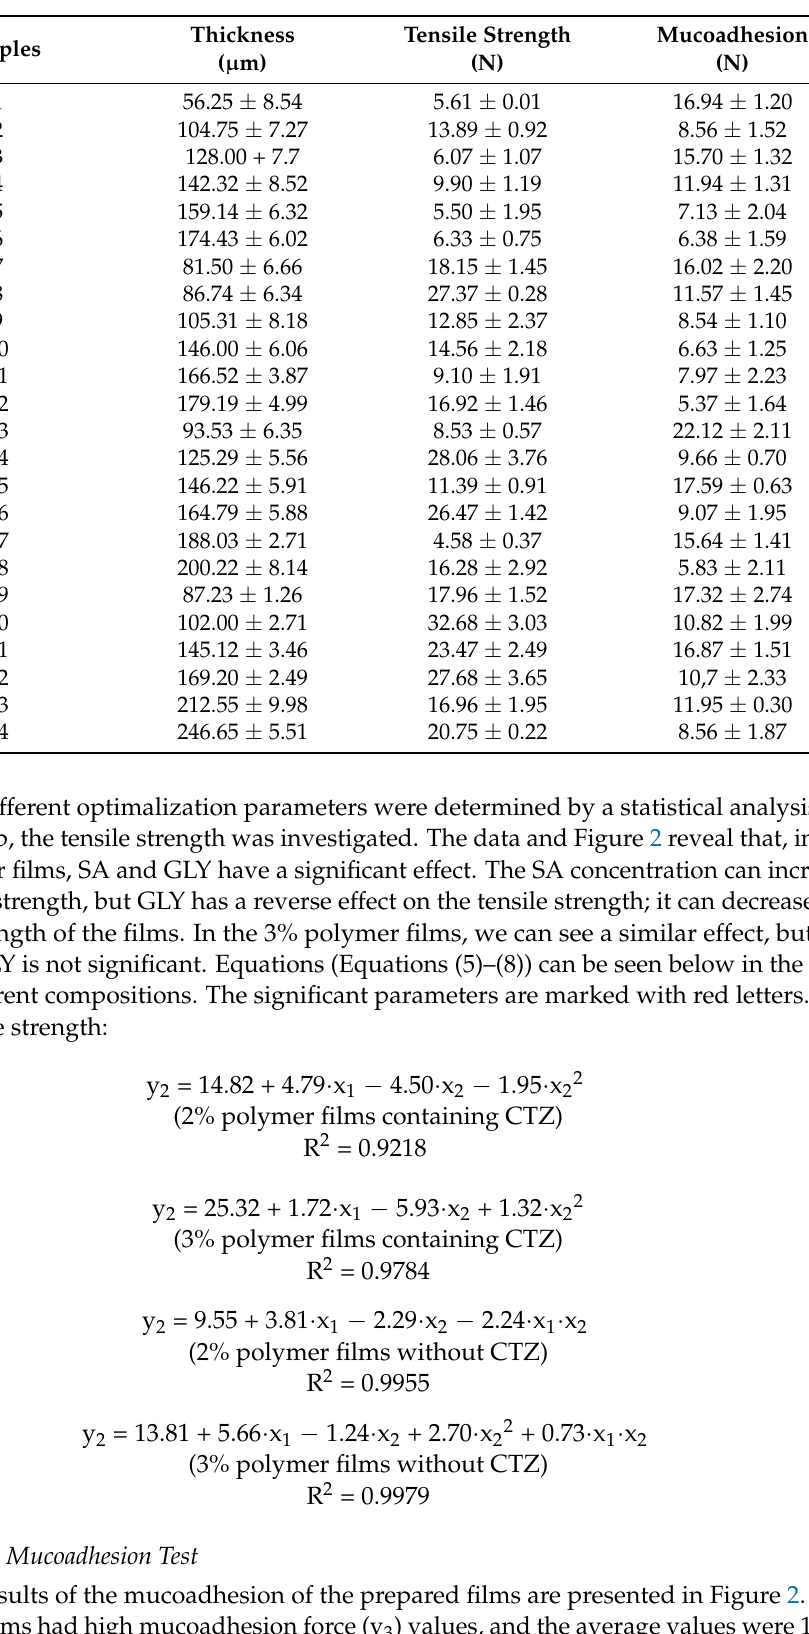
Table 3. Mechanical properties of the various polymer